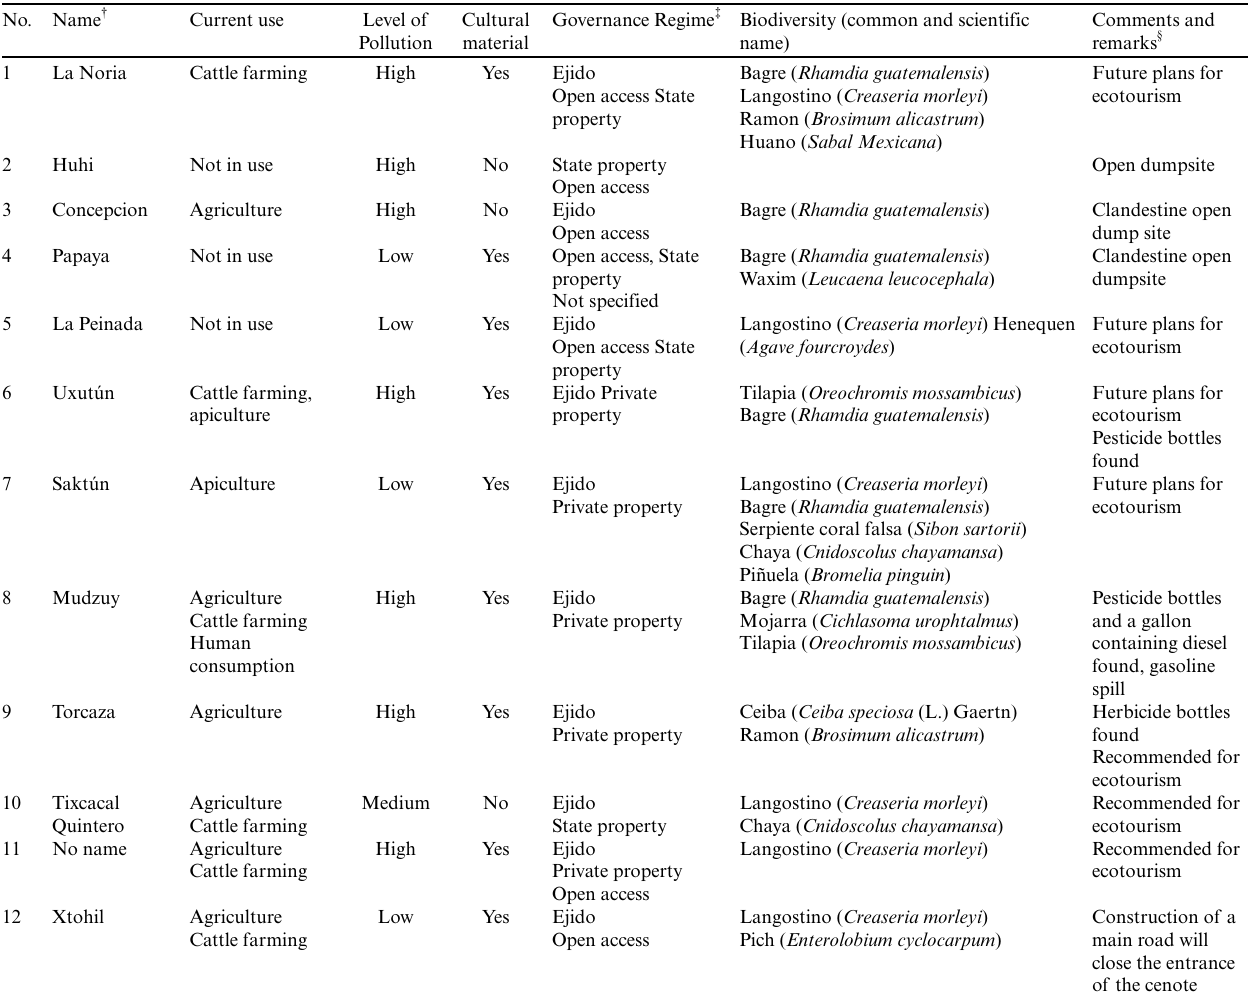
Table 3 . Characteristics and common uses of cenotes explored in the Geohydrological Reserve